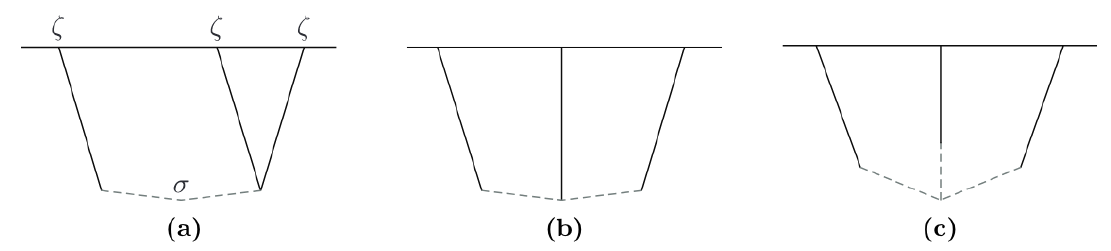
Figure 1. Tree-level diagrams ( a – c ) for single- double- and triple-exchange respectively contributing to the three-point correlator (cid:104) ζζζ (cid:105) . The diagrams represent the exchange of spin- s particles σ (dashed lines) with the curvature perturbation ζ (solid lines). Figure from